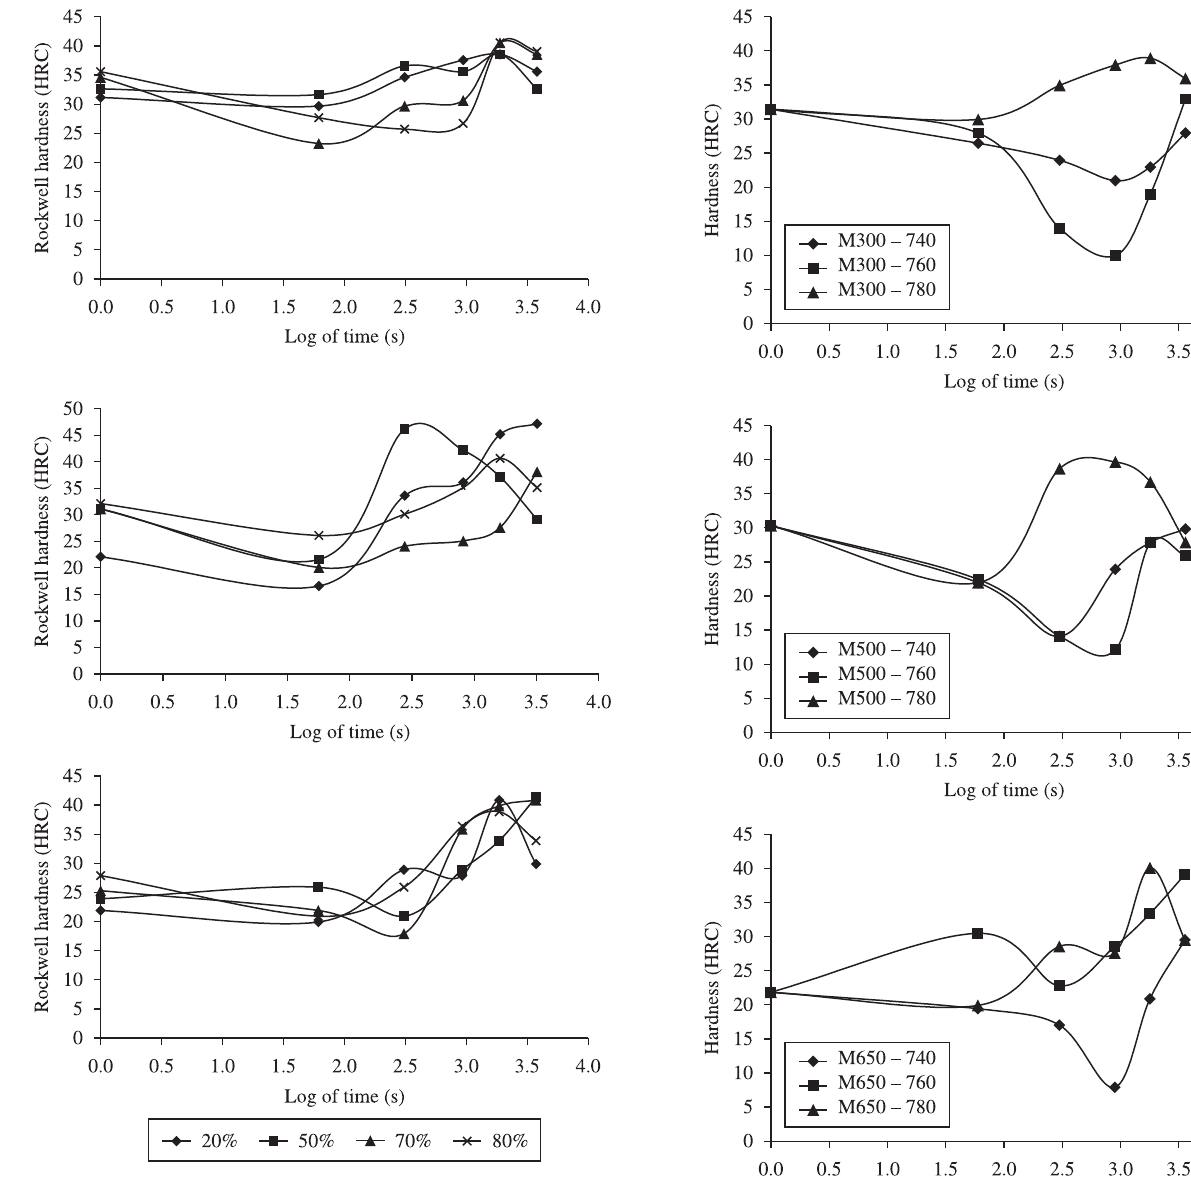
Figure 4. Rockwell hardeness vs. Annealing time plot for: a) 300 °C tempered martensite specimens treated at 780 °C; b) 500 °C tempered martensite specimens treated at 780 °C and c) 650 °C tempered martensite specimens treated at 780 °C.